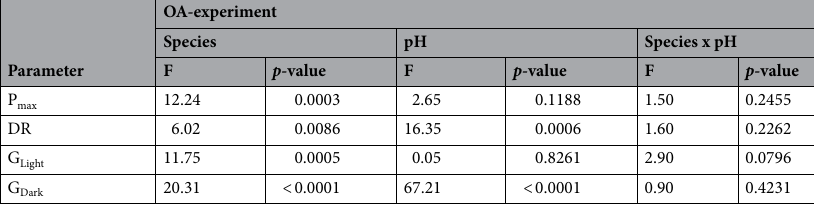
Table 3. Summary of the results of two-way ANOVA analyses, testing for differences in the species’ response to short-term OA-exposure (ambient vs. low seawater pH) (P max - maximum gross photosynthesis, DR- dark respiration, G Light and G Dark - light and dark calcification rates). Significant differences ( p < 0.05) are indicated in